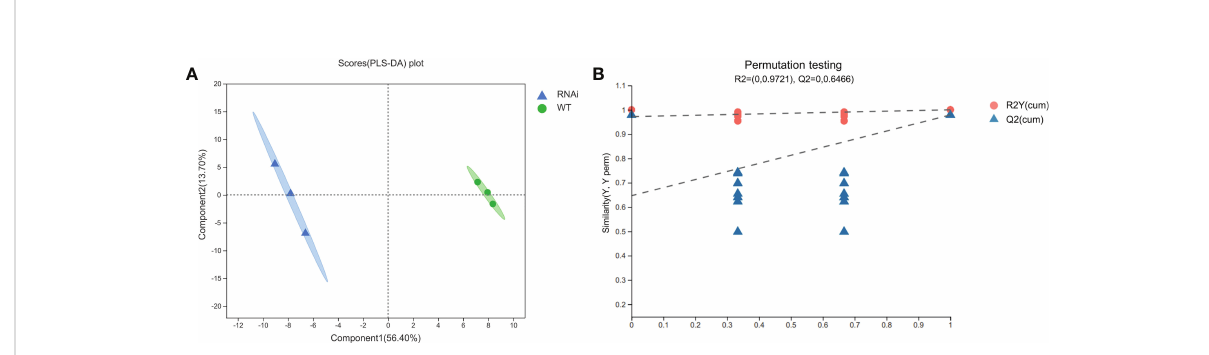
FIGURE 6 PLS-DA scoring models (A) and permutation test (B) of wild-type and transgenic rapeseed plants. Note: Component 1 denotes the fi rst principal component interpretation degree, and Component 2 denotes the second principal component interpretation degree. The contribution rate of Principal Component 1 is 56.40%, and the contribution rate of Principal Component 2 is